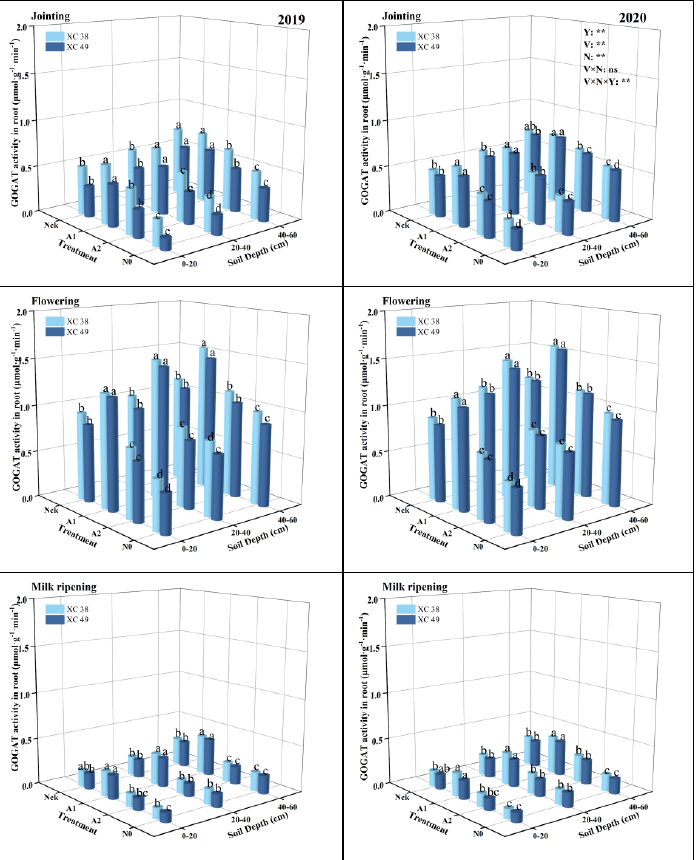
Figure 4. Effect of nitrogen supply on root GOGAT activity of drip-irrigated spring wheat. Note: XC 38: Xinchun 38; XC 49: Xinchun 49. Nck: 300 kg·ha −1 ; N0: 0 kg·ha −1 ; A1: 240 kg·ha −1 ; A2: 210 kg·ha −1 . V: variety, N: different nitrogen treatments, and Y: year. “**” indicates significant differences at 0.01 levels, ns indicates insignificant differences. Different lowercase letters indicate significant differences between treatments at the 0.05 level.